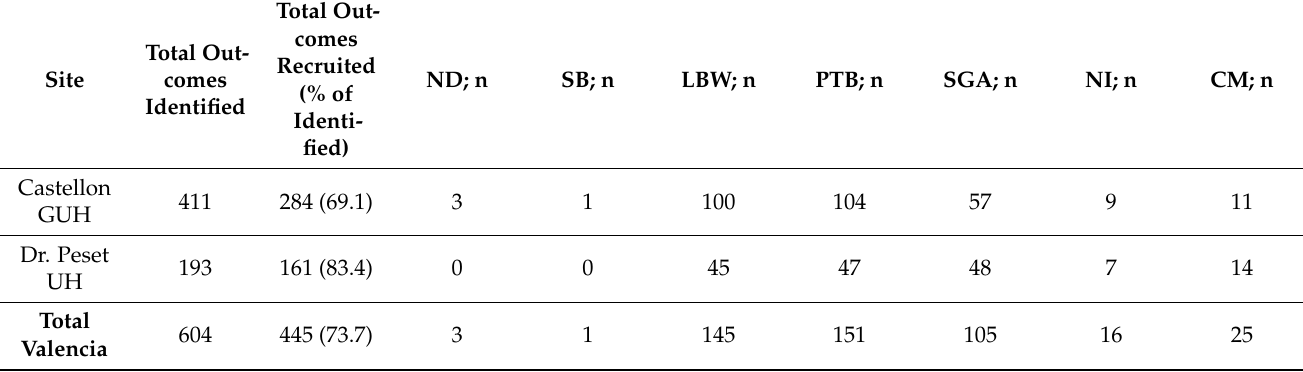
Table 6. Number of total perinatal and neonatal study outcomes recruited for the GAIA definitions applicability assessment during the study period. Number of total cases recruited in the GAIA definitions applicability assessment for each of the outcomes, per site and in total in Valencia